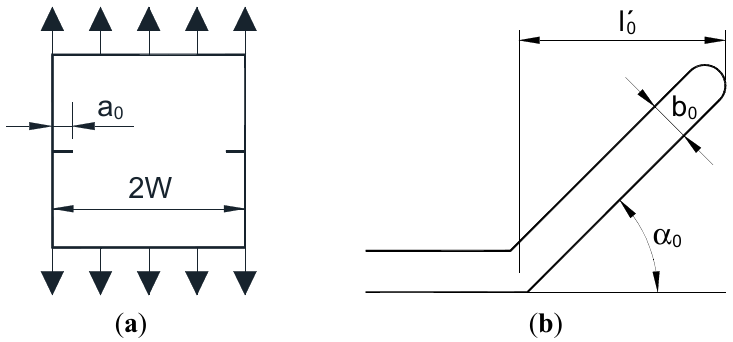
Figure 1. Initial geometry: ( a ) general view and ( b ) kinked crack tip.